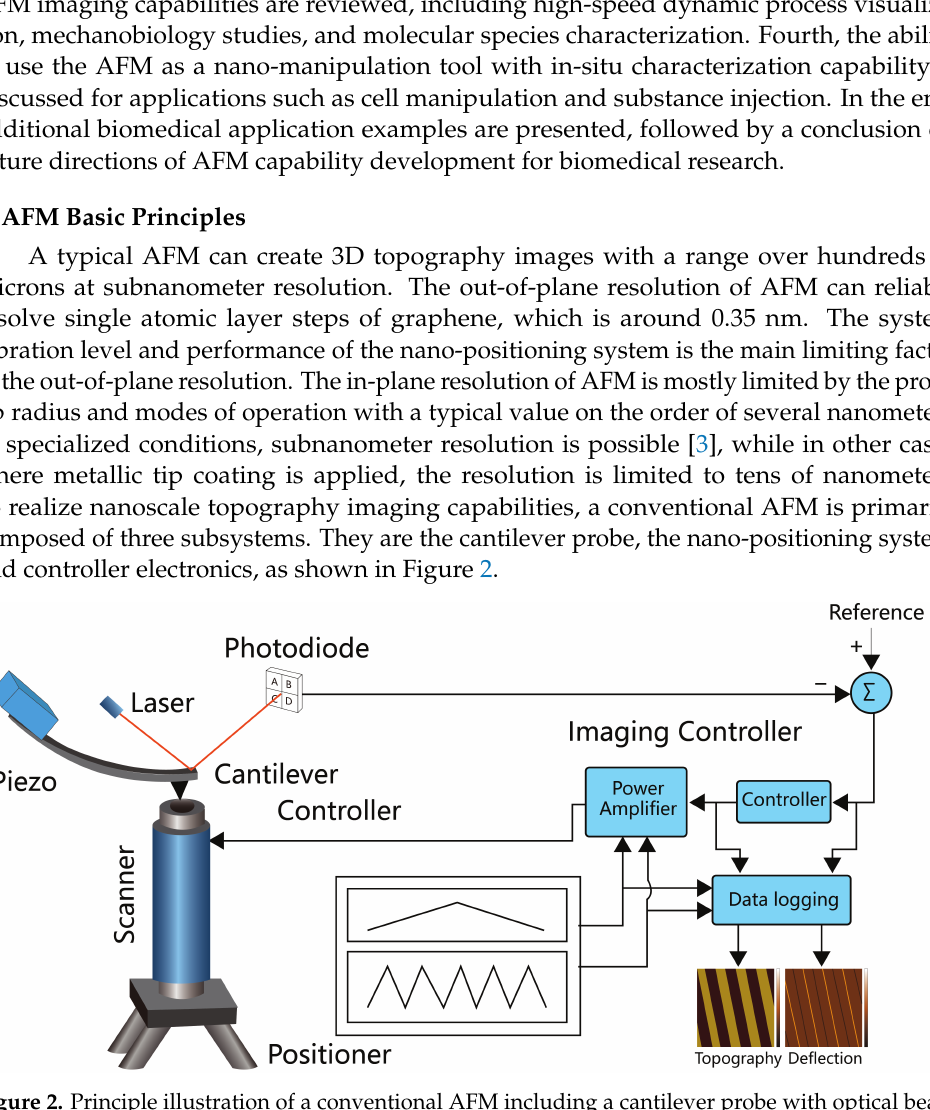
Figure 2. Principle illustration of a conventional AFM including a cantilever probe with optical beam deflection sensor and piezo-acoustic resonance excitation, a nanopositioning system, and an imaging motion